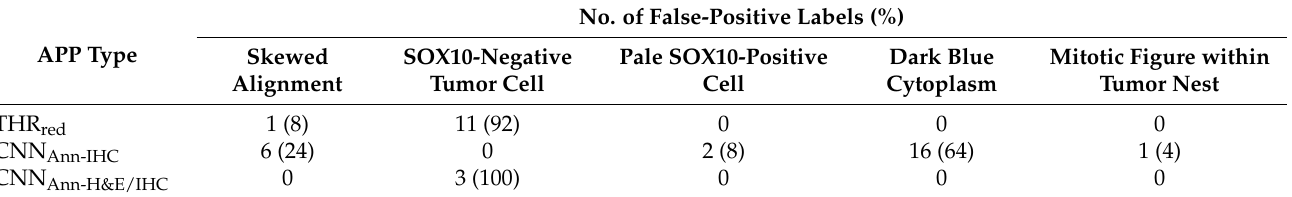
Table 4. Reasons for False-Positive Normal-Cell Annotations in Primary